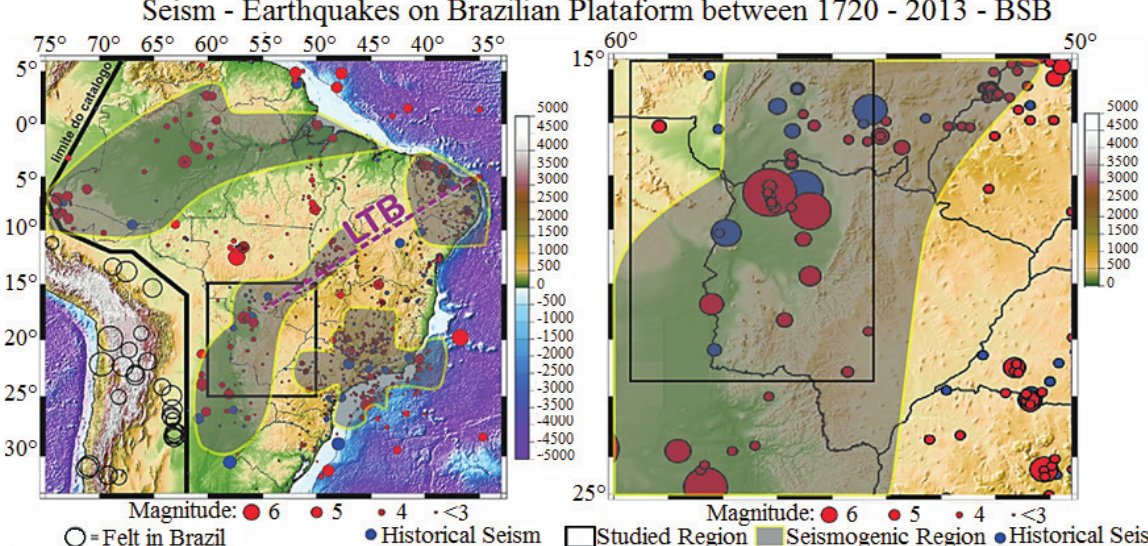
Figure 1 - Events recorded in the Brazilian Seismic Bulletin (BSB – V2014.6).